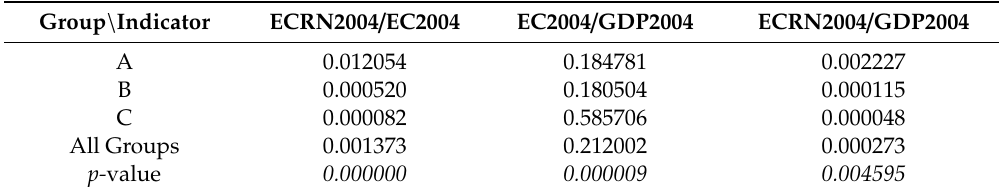
Table 10. Group averages for IREN in 2004.